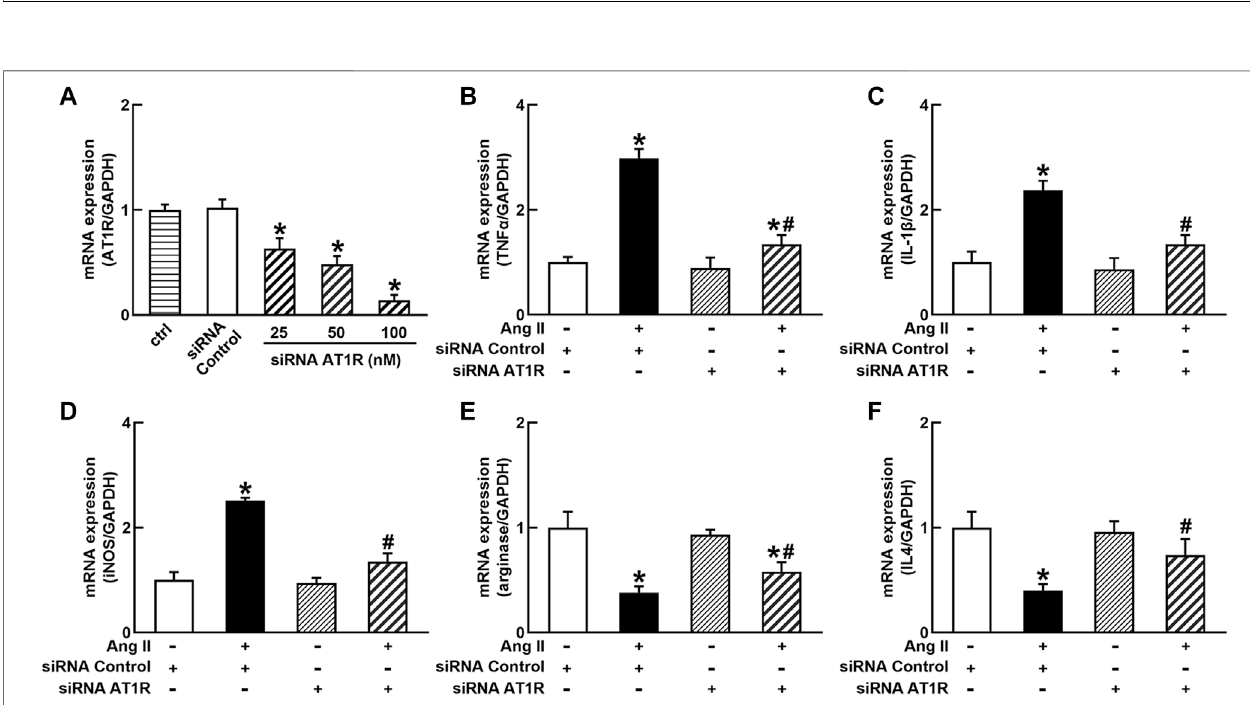
FIGURE 2 | Effects of silenced AT1R on the mRNA expressions of M1 and M2 macrophage cytokines in THP-1/macrophages. siRNA AT1R dose dependently reduced mRNA expression of AT1R (A) ; silenced AT1R gene prevented Ang II-induced increase in M1 cytokines TNF α (B) , IL-1 β (C) , and iNOS (D) ; silenced AT1R preventedAngII-induceddecreaseinmRNAexpressionsofM2cytokines,arginase (E) andIL4 (F) .Statisticalcomparisonswerecarriedoutwithone-wayANOVA (A) or two-way ANOVA (B – F) followed by the Tukey post hoc test. Data were expressed as mean ± SEM. N = 6, * p < 0.05 vs. siRNA control, # p < 0.05 vs. Ang II group.